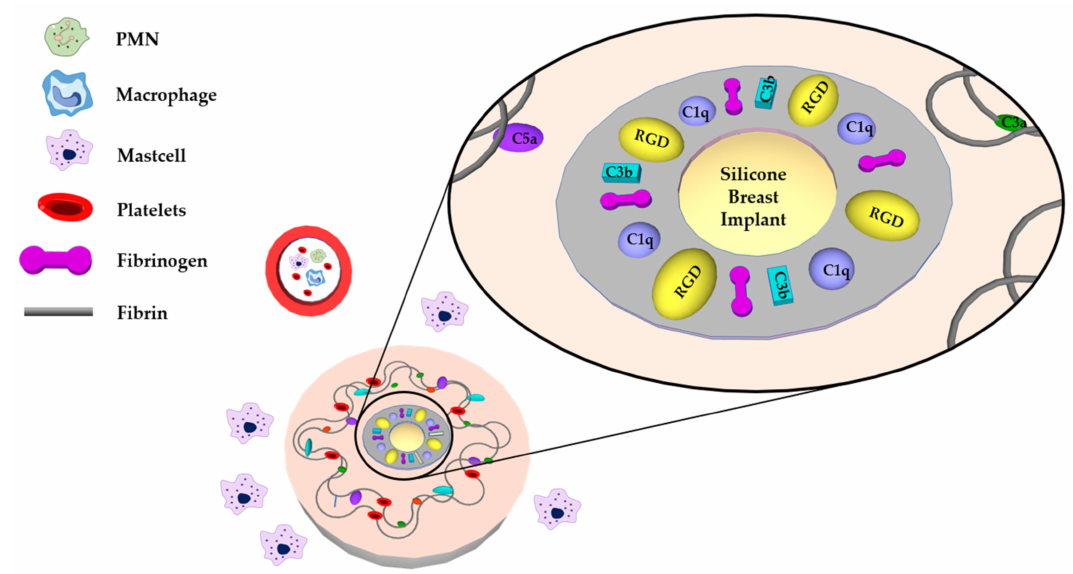
Figure 1. Schematic illustration of Phase 1 after implantation-initiated foreign body reaction and synthesis of a matrix around silicone breast implant. Reproduced with permission from